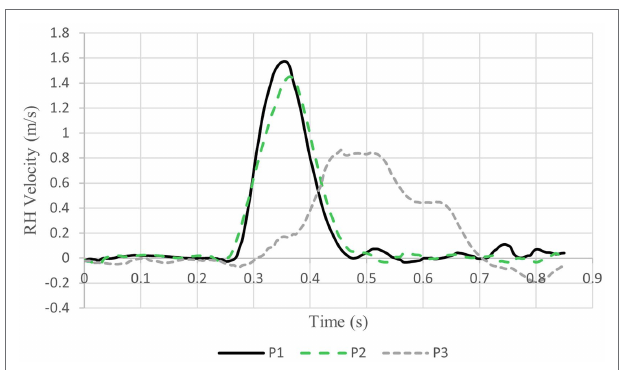
FIGURE 4 | RH velocity for all pianists during section C at 10